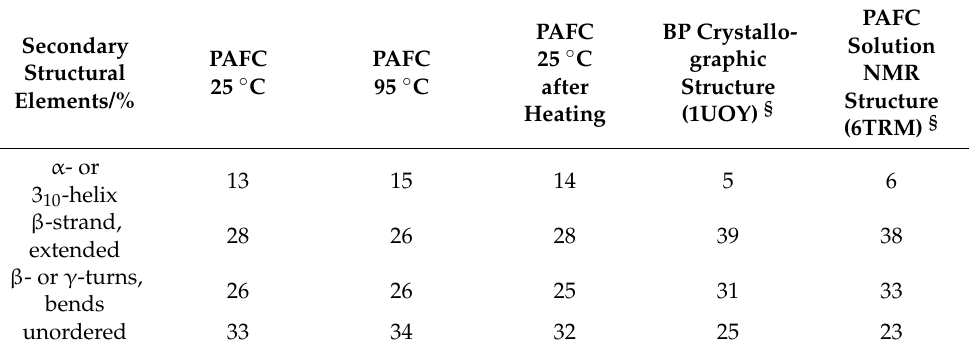
Table 2. Estimation of secondary structural components of PAFC from ECD spectra compared to those obtained from NMR